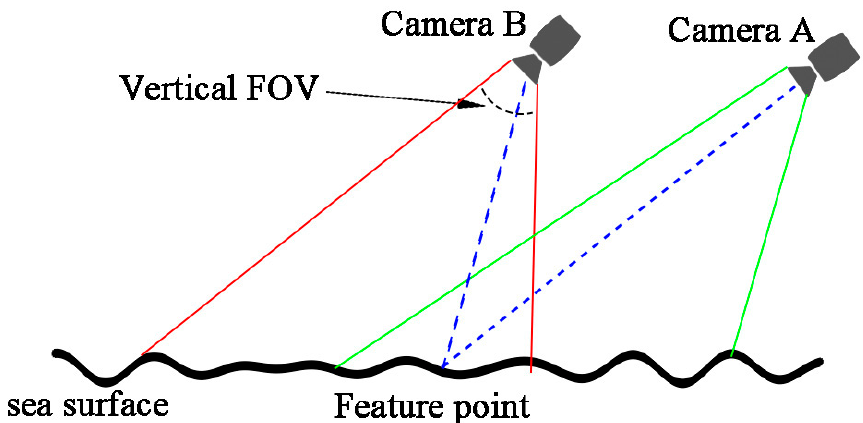
Figure 25. Inappropriate viewing angle cause strong parallax.